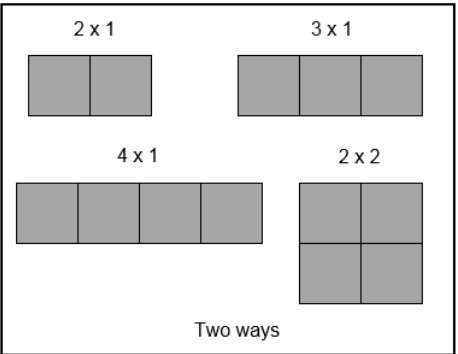
Figure 4. Arrays for 2 tiles, three tiles and four